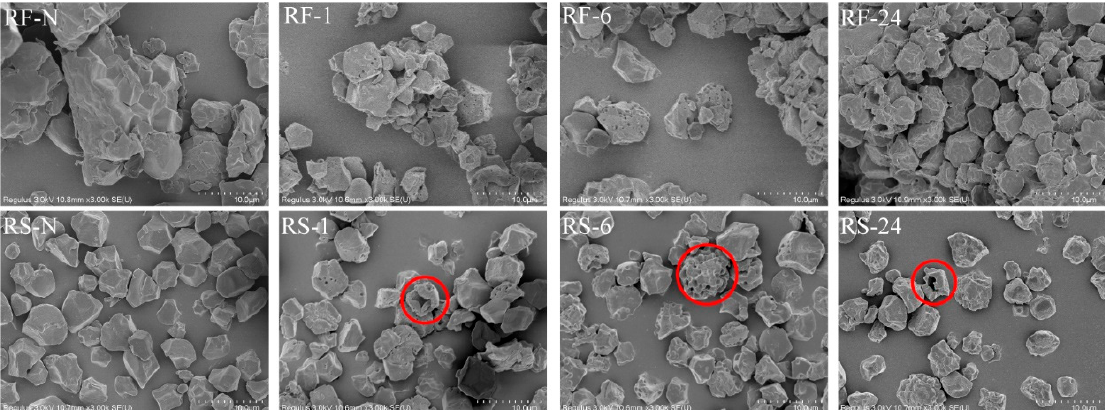
Figure 1. Morphological structure of native and partially hydrolyzed RF and RS at Χ 3000 magnifi- cation. The upper left abbreviations are sample names, in which RF represents rice flour and RS represents rice starch; numbers refer to the hydrolysis time (h); RF-N is native rice flour and RS-N is native starch isolated from rice flour. The red lines circle the numerous pore structures or hollow shells formed by simultaneous hydrolysis on a single starch granule.